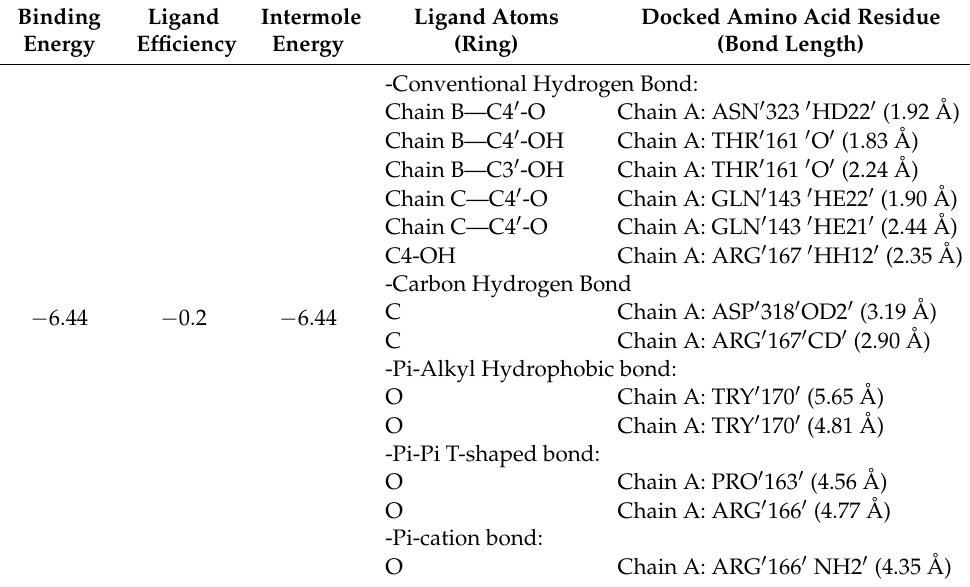
Table 2. Interactions of orientin and PTEN receptor residues of target